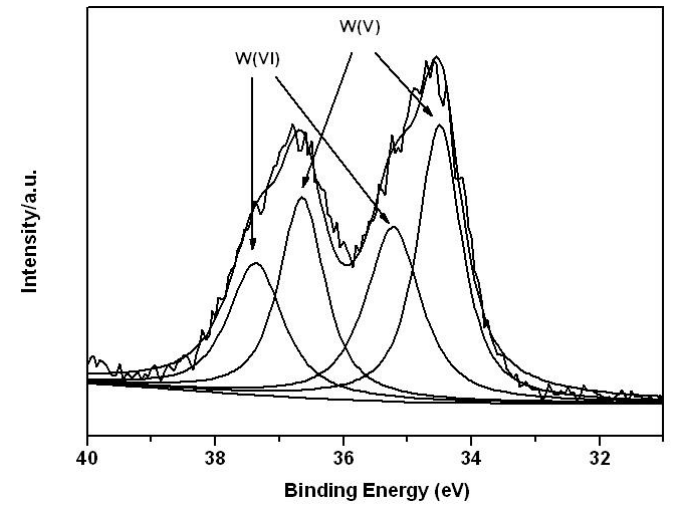
Figure 4. XPS spectrum of the W 4f region for the catalyst.